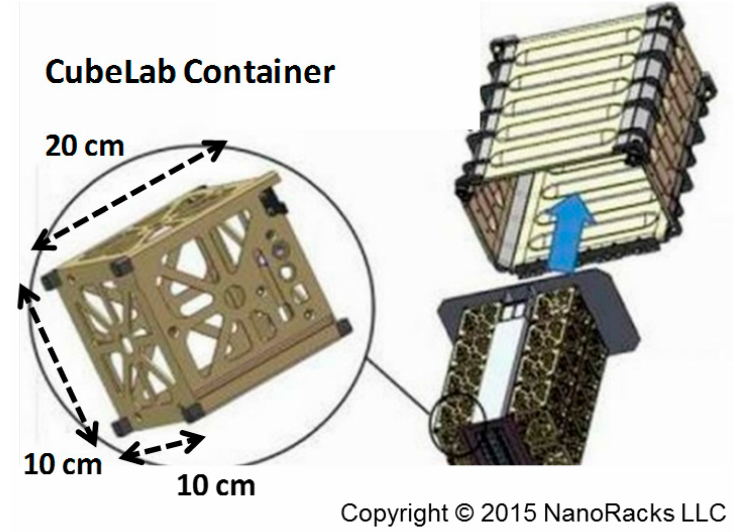
Figure 8. Schematic and dimensions of CubeLab and NanoRack